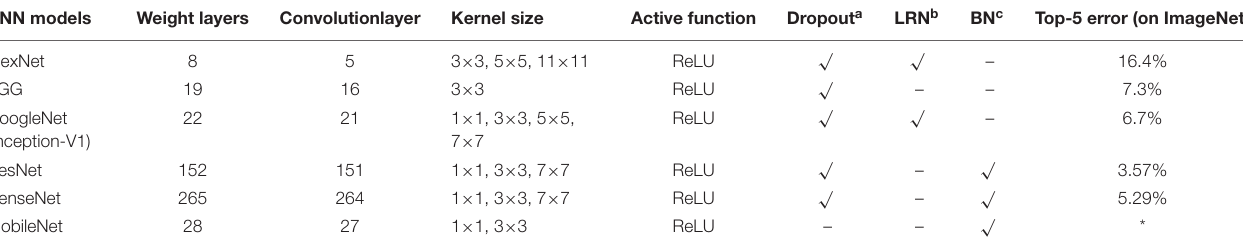
TABLE 1 | Structure and performance of common convolutional neural network (CNN) models for image detection. CNN